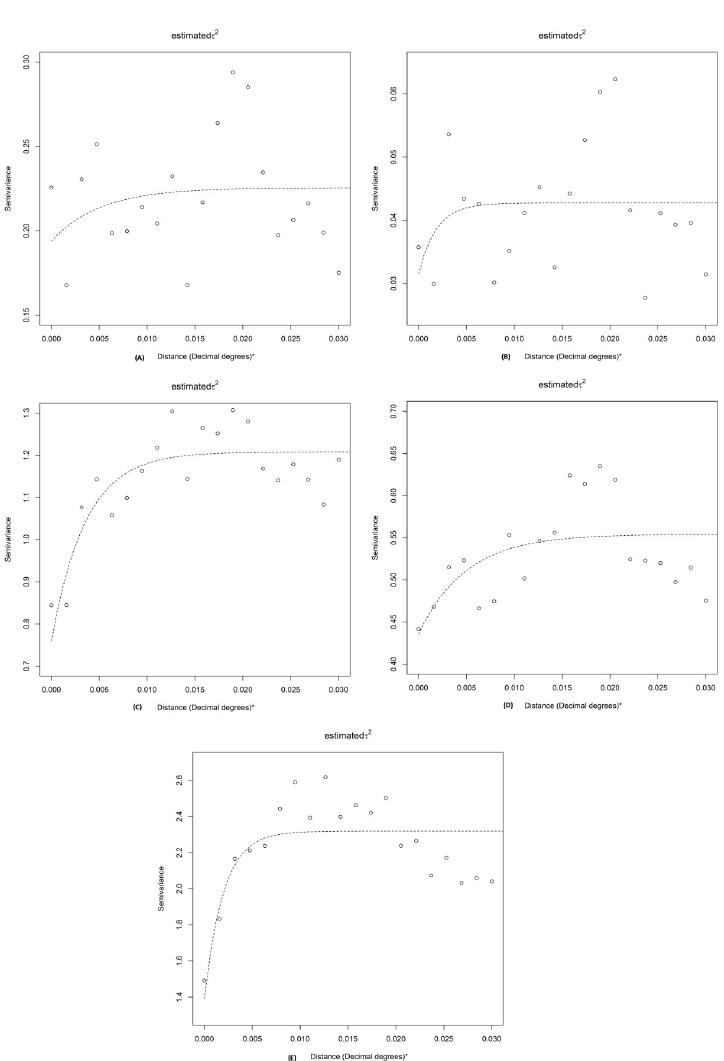
Fig 7. Semivariograms of spatial autocorrelation of A) lymphatic filariasis Ag, B) Mf, C) Wb123 Ab, D) Bm14 Ab and E) Bm33 Ab, American Samoa 2016. (One decimal degree at the equator is approximately 111Km).